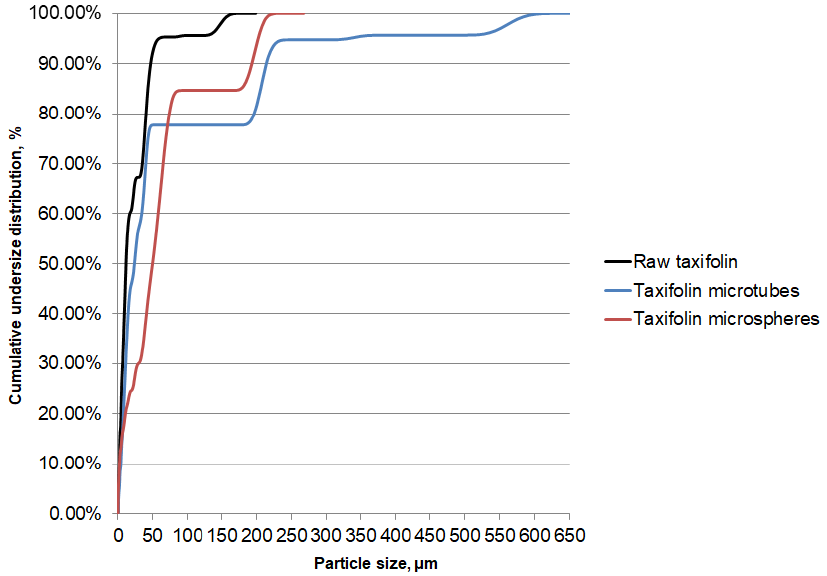
Figure 3. Cumulative undersize distribution of particles of different taxifolin forms.